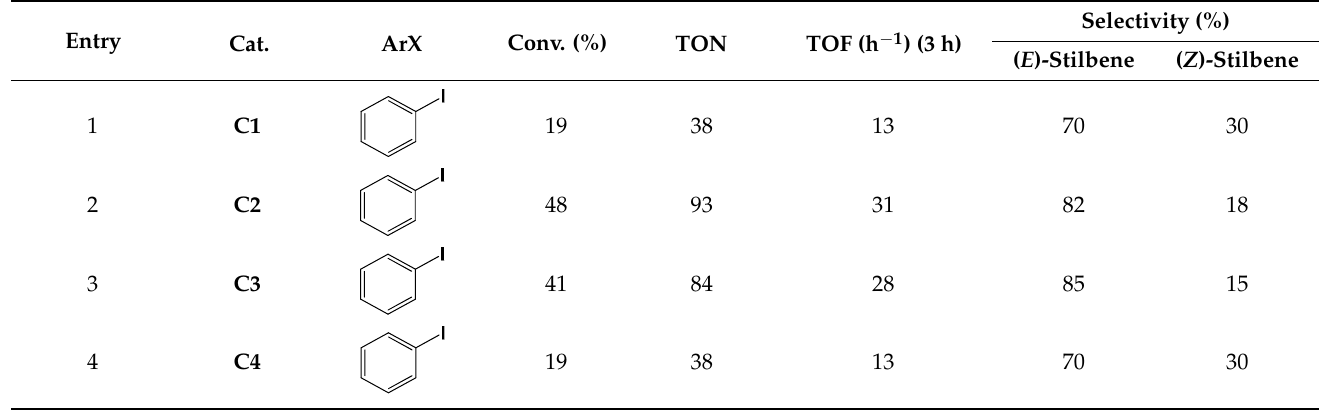
The cross ‐ coupling of iodobenzene with the 4 ‐ chlorostyrene (Figure 14) using C1 – C4